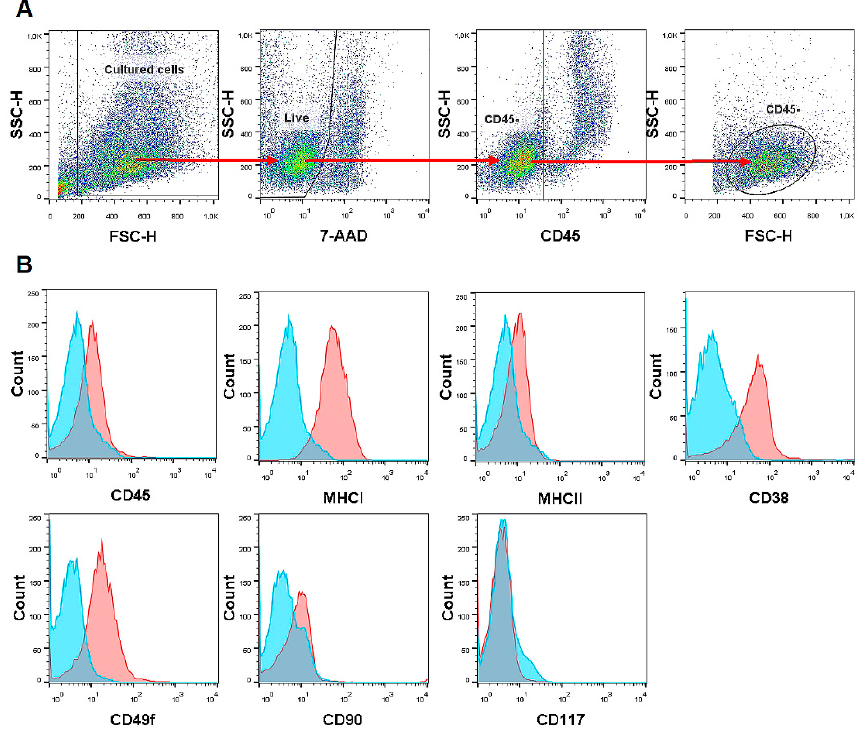
Figure 4. Evaluation strategy for the phenotyping of cultured CD45 − cells. Firstly, live cultured cells were gated, then only CD45 − cells were shown on FSC/SSC dot-plot ( A ) and cells from this region were analyzed for the expression of specific markers ( B ). Blue: control, red: specific marker.